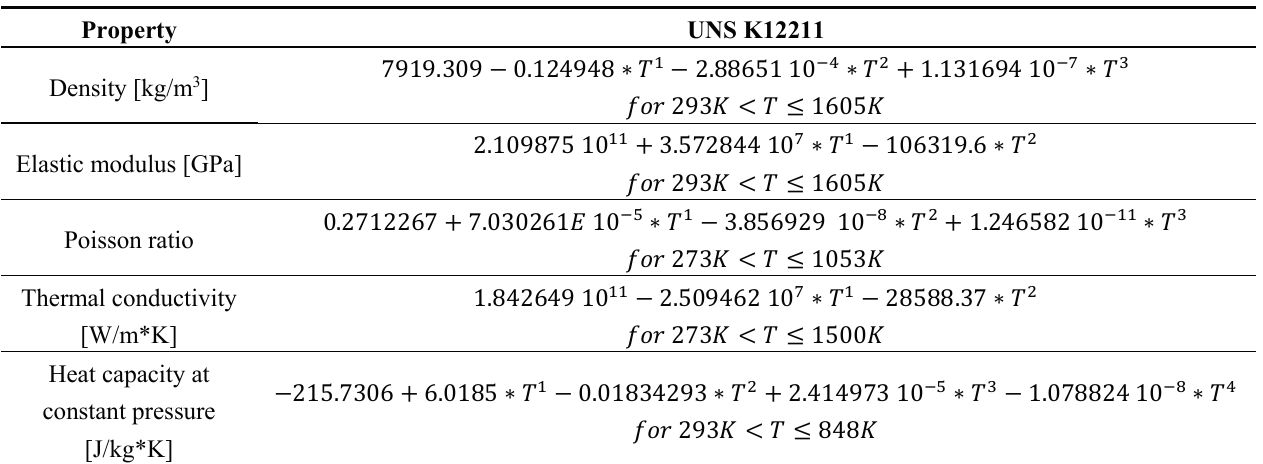
Figure 16. ( a ) Temperature distribution in plate and waveguide and ( b ) comparison of signals at room temperature and with elevated temperature. Table 3. Temperature-dependent material